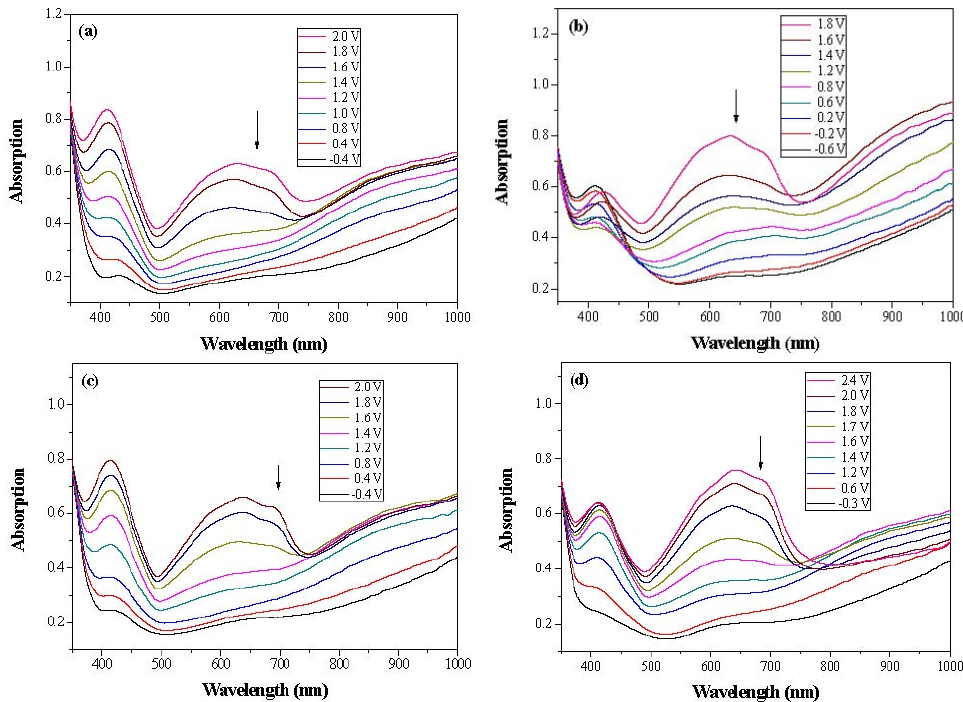
Figure 8. UV–Vis spectra of ( a ) PbCmB/PEDOT, ( b ) P(bCmB- co -bTP)/PEDOT, ( c ) P(bCmB- co - dbBT)/PEDOT, and ( d ) P(bCmB- co -TF)/PEDOT ECDs.